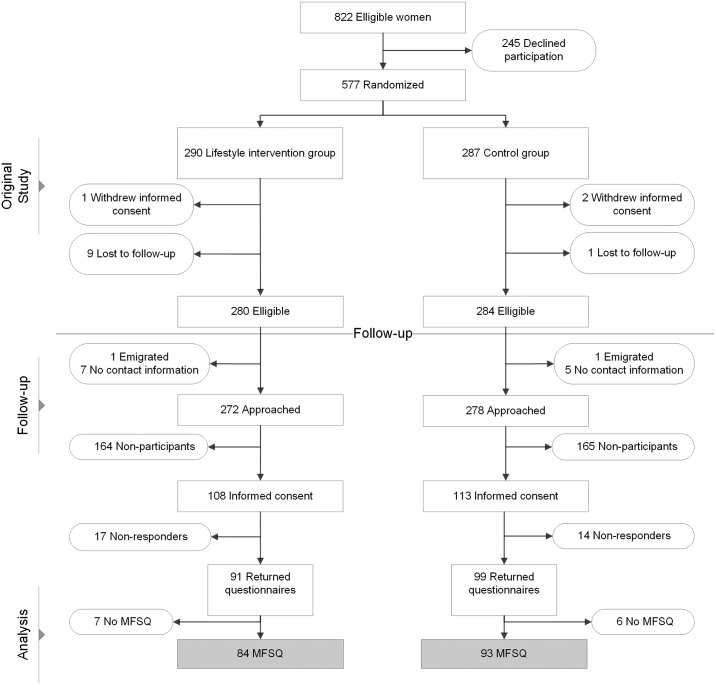
Flowchart of participants.Abbreviations: MFSQ, McCoy Female Sexuality Questionnaire.